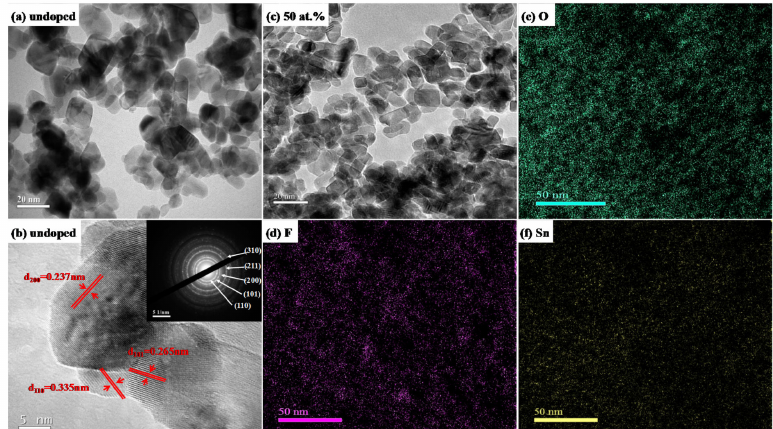
Figure 2. Transmission electron micrograph (TEM) images, high resolution transmission electron microscopy (HRTEM), selected area electron diffraction (SAED) pattern, and electron energy loss spectroscopy (EELS) maps of SnO 2 and FTO NPs: ( a ) TEM image of SnO 2 NPs; ( b ) HRTEM image with inset SAED pattern of SnO 2 NPs; ( c ) TEM image of FTO NPs with 50 at. % F doping; ( d – f ) F, O and Sn EELS element mapping of FTO NPs with 50 at. % F doping,